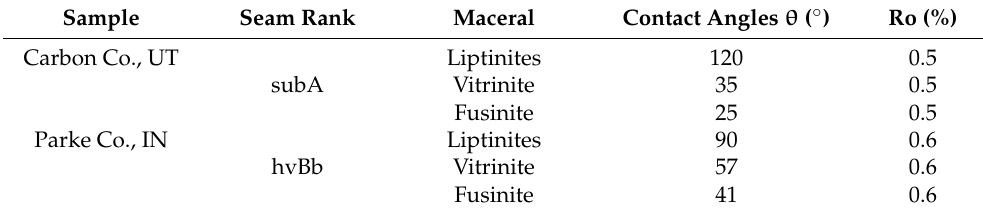
Table 1. Comparison of contact angles of exinite, vitrinite and inertinite in coals (data from [142]). Sample Seam Rank Maceral Contact Angles θ ( ◦ ) Ro (%) Carbon Co., UT Liptinites 120 0.5 subA Vitrinite 35 0.5 Fusinite 25 0.5 Parke Co., IN Liptinites 90 0.6 hvBb Vitrinite 57 0.6 Fusinite 41